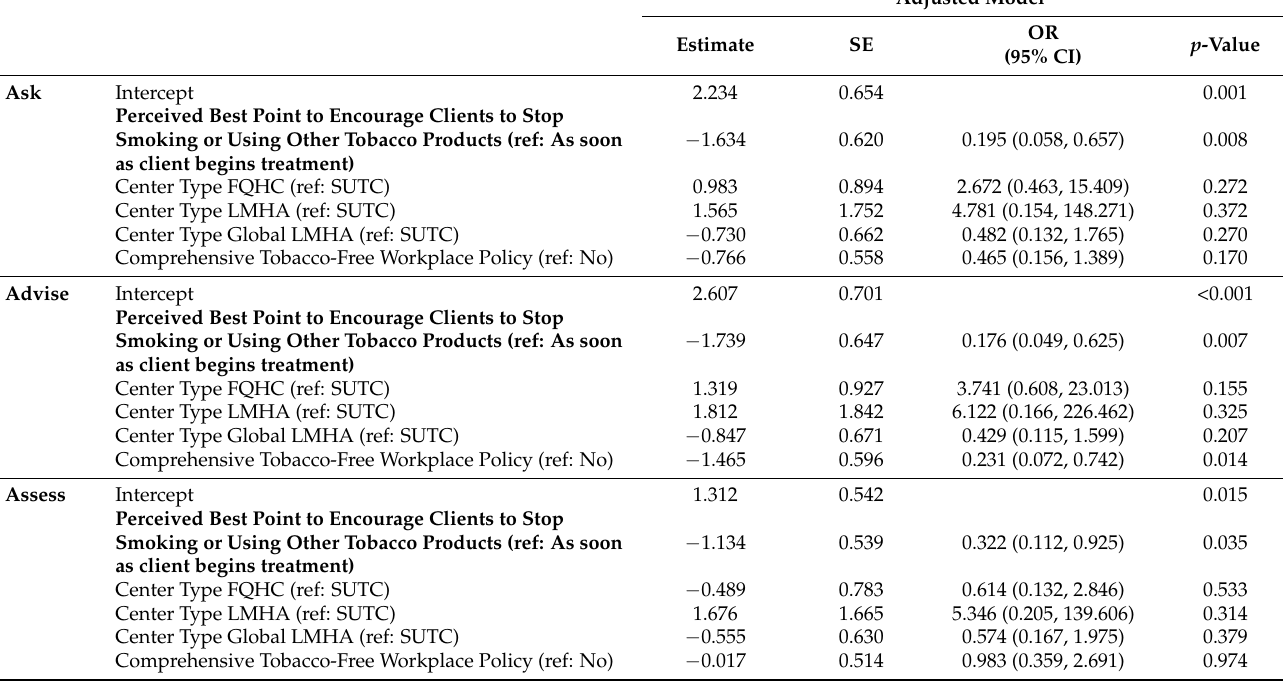
Table 2. Texas Substance-Use Treatment Providers’ Smoking Intervention Practices with Clients Relative to Their Perceptions of Concurrent Smoking/Tobacco Cessation and Non-Nicotine-Substance-Use